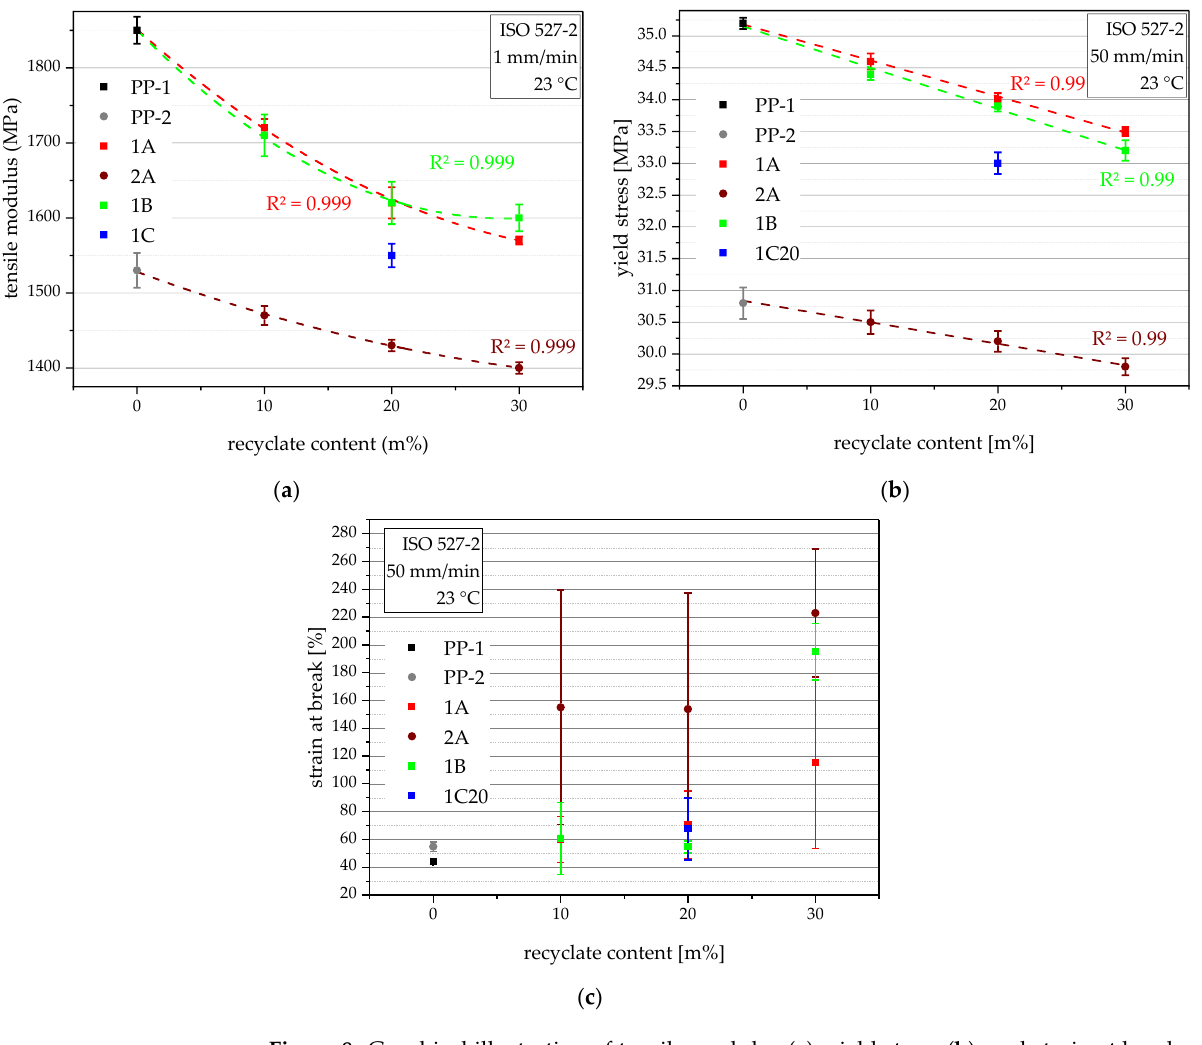
Figure 8. Graphical illustration of tensile modulus ( a ), yield stress ( b ), and strain at break values ( c ) of the virgin blending partners PP-1 and PP-2 (as 0 m% recyclate content data points) and all compounds. The vertical bars show the sample standard deviations. Polynomial ( a ) and linear ( b ) approximations depicting the three distinguished compounding series (1A, 2A, 1B) are plotted as dashed lines, and the respective R 2 values are shown in matching colors.